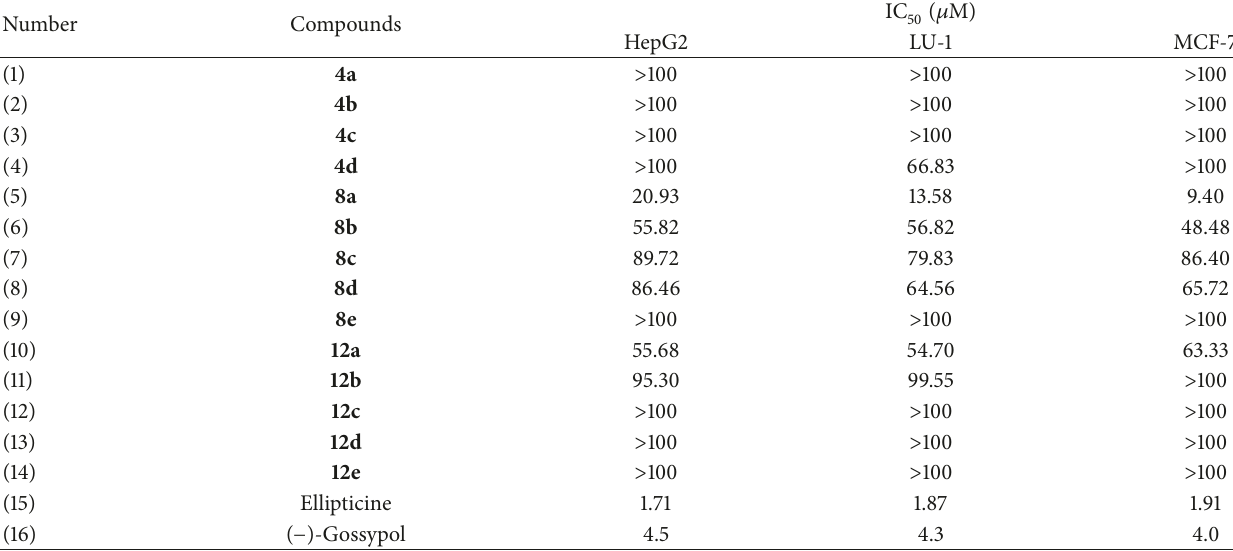
Table 1: Cytotoxic activity of target compounds.